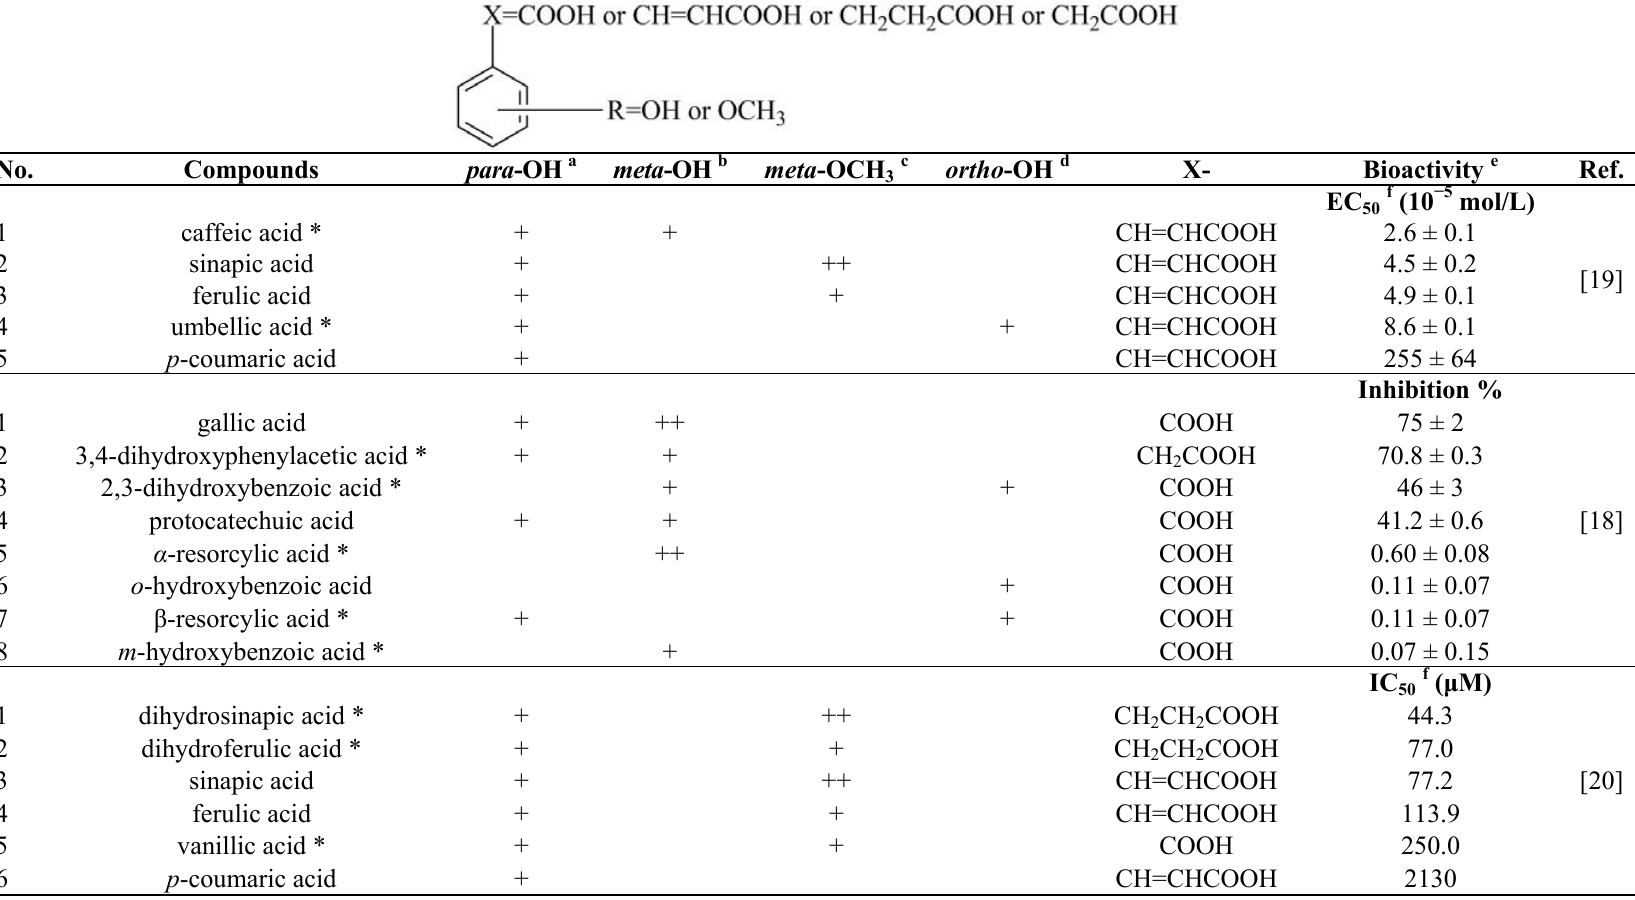
Table 3. Confirmation of functional structures and their DPPH • scavenging activities based on data from previous publications.